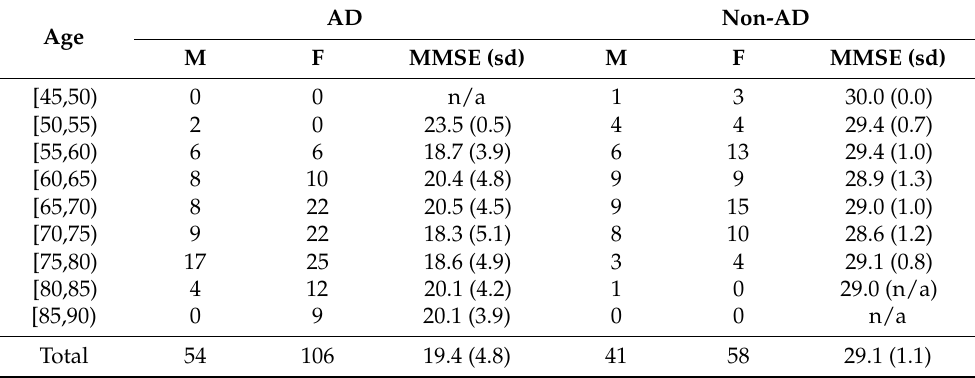
Table 2. Basic characteristics of subjects for DementiaBank Pitt database. n/a: not